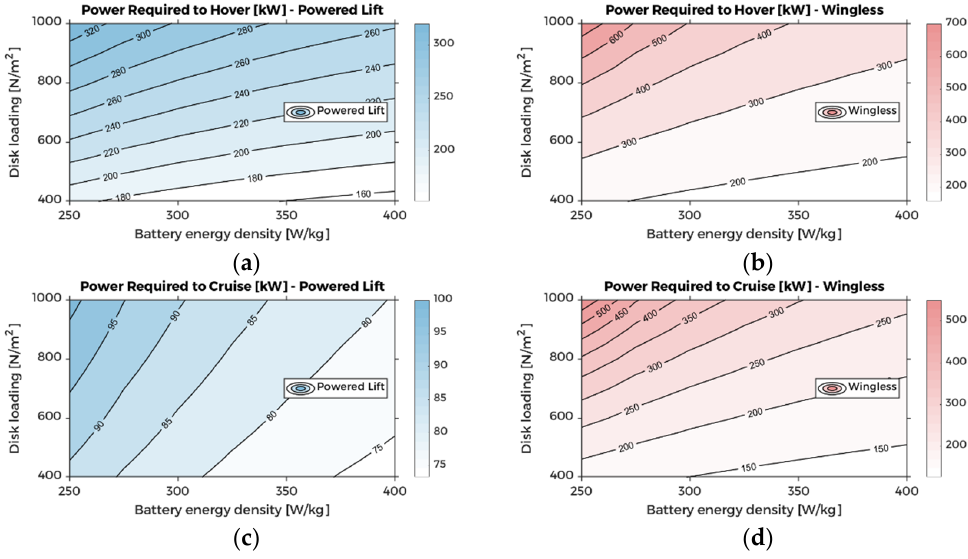
Figure 8 . Battery energy density vs. disk loading sensitivity plots for ( a ) powered lift and ( b ) wingless hover power, and ( c ) powered lift and ( d ) wingless cruise power.